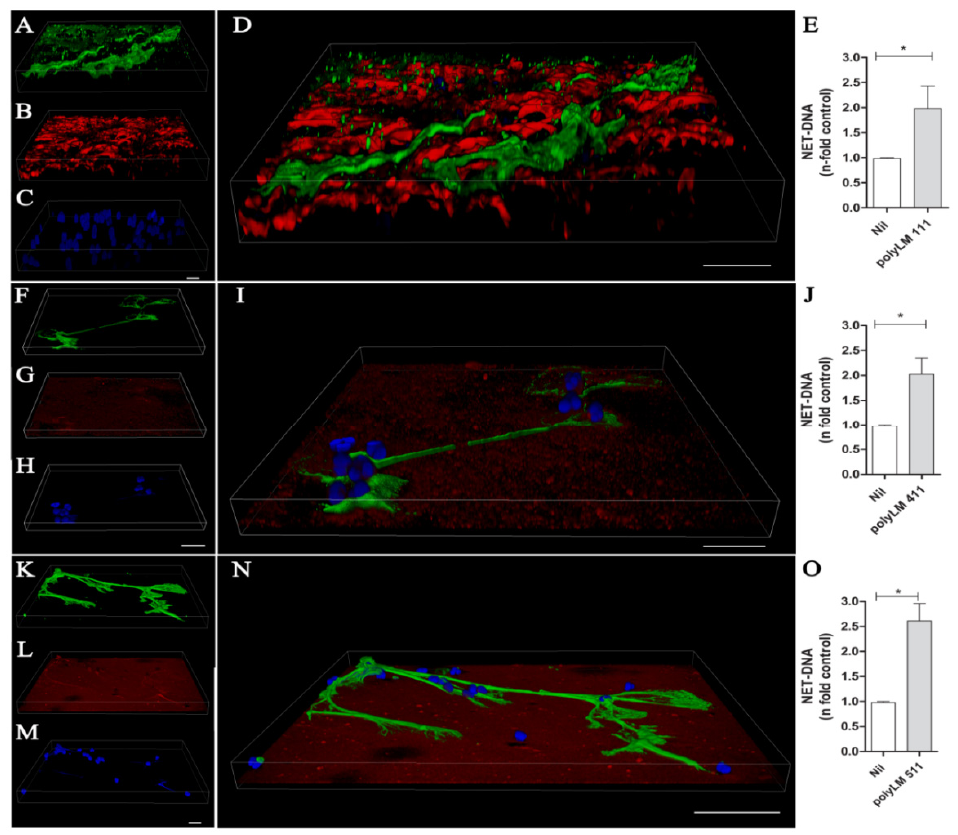
Figure 5. Polymerized laminins (polyLM) 111, 411, and 511 trigger NET release. Neutrophils